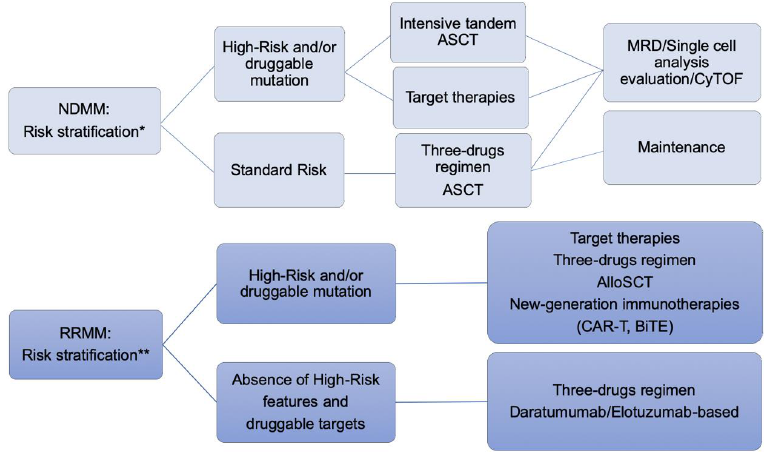
Figure 5. Clinical trial design proposal for a risk-driven personalized approach. NDMM: newly-diagnosed MM. RRMM: relapsed-refractory MM. ASCT: autologous stem cell transplantation. Allo-SCT: allogeneic stem cell transplantation. MRD: minimal residual disease. * FISH, NGS (genomic panels including known actionable mutation and TP53 mutation), and GEP. ** FISH, NGS (genomic panels including known actionable mutation and TP53 mutation and drug resistance-related genomic alterations), and GEP. CAR-T: Chimeric Antigen Receptor T cell; BiTE: Bispecific T cell engager antibody; tandem ASCT: double autologous stem cell transplantation. Tandem ASCT is already being investigated in experimental